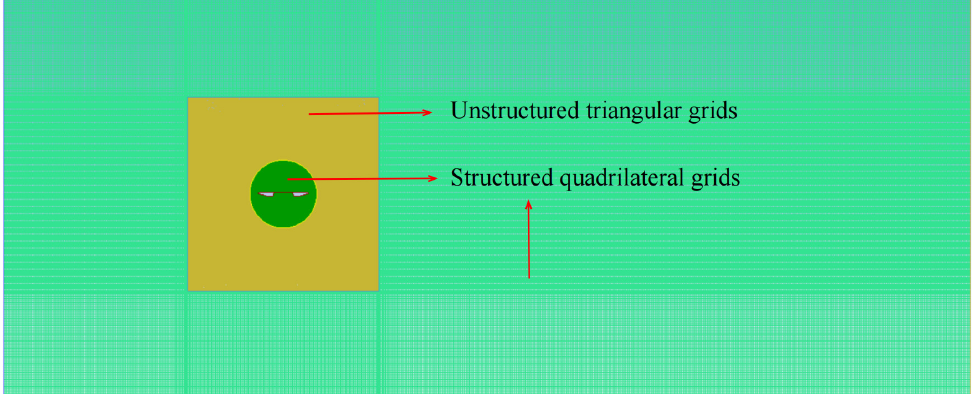
Figure 3. Grid of the whole computational domain.